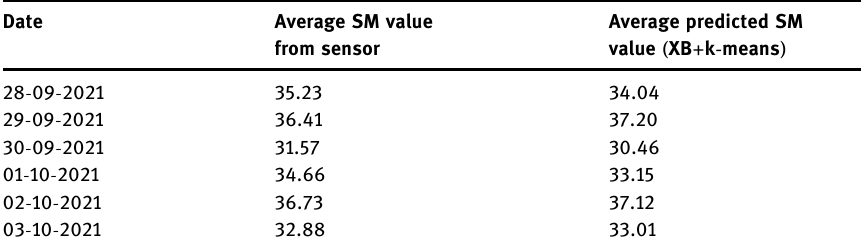
Table 2: Comparison of predicted SM value with actual SM value